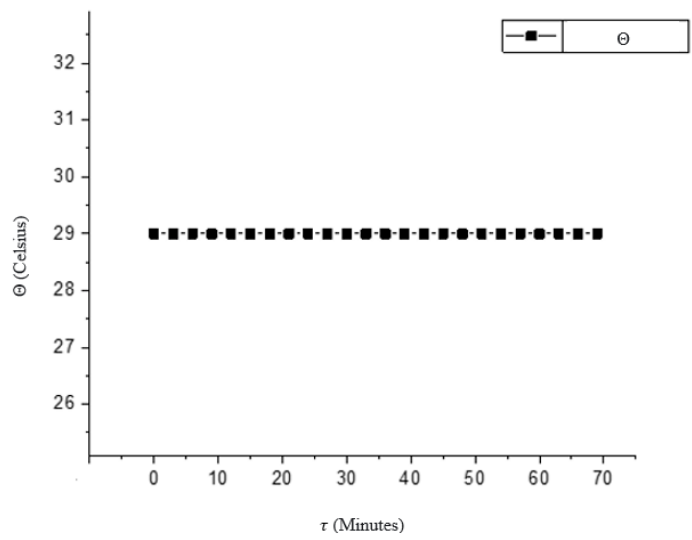
Figure 10. Characterization of irradiation temperature against time .